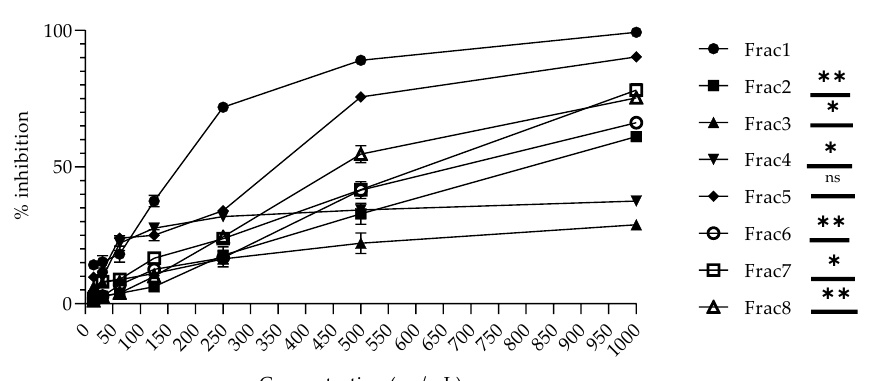
Figure 2. Cytotoxicity of M. inermis and T. indica fractions against HepG2 cell lines: No significant difference: ns , p > 0.05; significant differences: *, p < 0.05; **, p < 0.01. Frac1 : decoction of M. inermis leaves; Frac2 : additional ethyl acetate + butanol + acetone fractions of M. inermis leaves; Frac3 : additional ethyl acetate + acetone fractions of M. inermis stem; Frac4 : additional ethyl acetate + acetone fractions of M. inermis root; Frac5 : additional ethyl acetate + butanol fractions of T. i ndica leaves; Frac6 : acetone fraction of T. indica leaves ; Frac7 : additional ethyl acetate + acetone fractions of T. i ndica stem; Frac8 : additional ethyl acetate + acetone fractions of T. indica root; M. inermis , Mitragyna inermis ; T. indica , Tamarindus indica